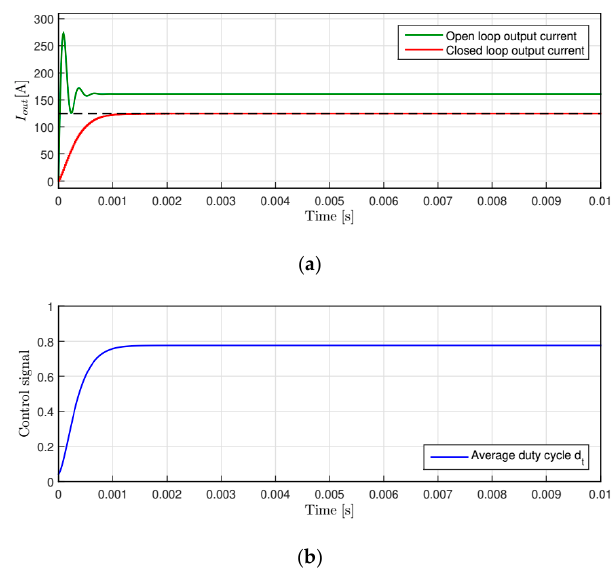
Figure 7. ( a ) Open-loop step response (green), closed-loop step response (red) and ( b ) the corresponding average duty cycle d t ( t ) (blue).